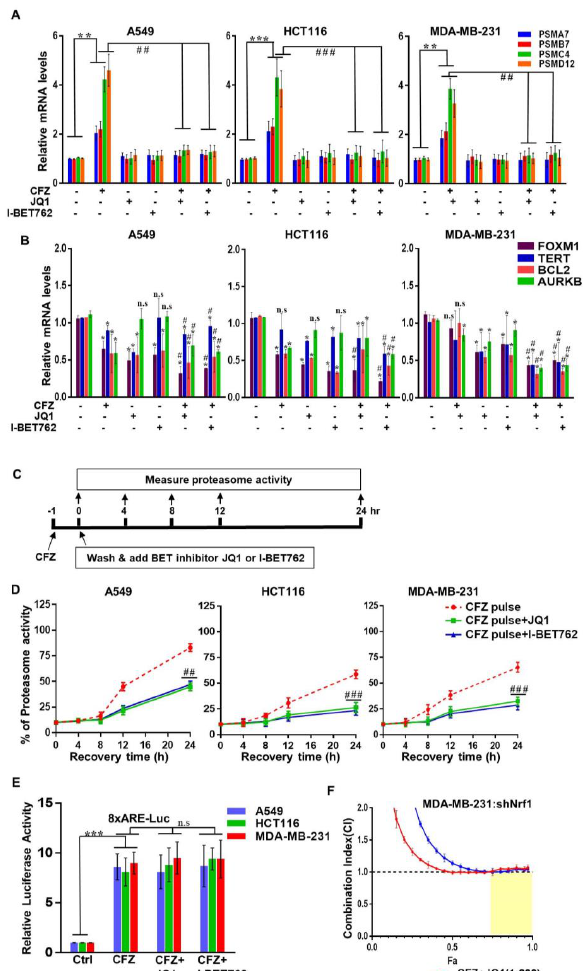
Figure 2. BET inhibitors impair Nrf1-mediated induction of proteasome genes and recovery of proteasome activity in response to CFZ. The A549, HCT116, and MDA-MB-231 cells were treated with CFZ (200 nM) alone and in combination with I-BET762 (10 µ M) and JQ1 (1 µ M) for 8 h. The DMSO treatment was used as vehicle control. Following treatments, RNA was extracted from cells and analyzed for representative proteasome subunit ( A ), BET target ( B ) mRNA levels with gene specific primers using quantitative RT-PCR. The 18s rRNA tanscript levels were used for normalization. Error bars denote SD ( n = 3); ( C ) A schematic representation of the proteasome recovery assays is shown; ( D ) A549, HCT116, and MDA-MB-231 cells were treated with 20 nM CFZ for 1 h (pulse treatment). The drugs were, then, washed out and the cells were allowed to recover in the absence or presence of I-BET762(10 µ M) and JQ1 (1 µ M) for 0, 4, 8, 12, and 24 h. Proteasome activity was measured at indicated time points and normalized to DMSO treated control cells. Error bars denote SD ( n = 3); ( E ) A549, HCT116, and MDA-MB-231 cells were transiently transfected with a firefly luciferase construct driven by eight repeats of the antioxidant response element (8xARE-Luc) along with a renilla luciferase construct. Forty-eight hours after transfection, cells were treated overnight with CFZ (200 nM) alone or in combination with JQ1 (1 µ M) or I-BET762 (10 µ M) as indicated. Dual luciferase assays were, then, performed to measure the firefly and renilla luciferase activity values. Normalized luciferase activity is shown. Error bars denote SD ( n = 3); ( F ) MDA-MB-231-shNrf1 cells were treated with di ff erent doses of CFZ (0.5, 2, 8, and 32 nM), along with one of the BET inhibitors (I-BET762, JQ1) in di ff erent doses (0.1, 0.4, 1.6, and 6.4 µ M) for 72 h. The combination index (CI) and fraction a ff ected (Fa) values were determined using CompuSyn software from cell viability data, and are shown in the graph. The results are shown as mean ± SD, n = 3. CI < 1.0 indicates synergism, CI = 1.0 indicates additive e ff ect, and CI > 1.0 indicates antagonism. *, p < 0.05, **, p < 0.005, ***, and p < 0.0005 as compared with controls; #, p < 0.05, ##, p < 0.005, and ###, p < 0.0005 as compared with the CFZ-treated